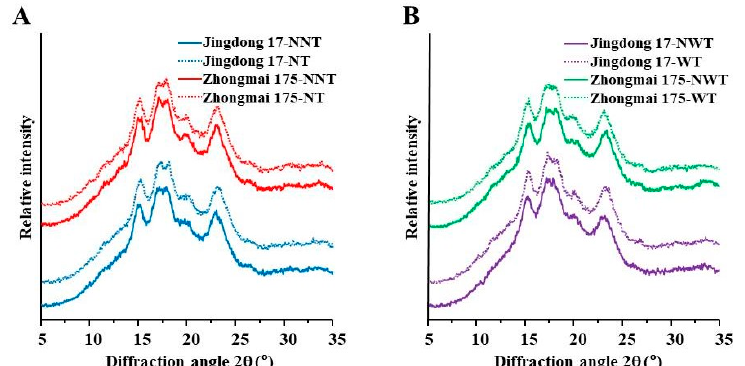
Figure 2. X-ray diffraction spectra of starch granules extracted from Zhongmai 175 and Jingdong 17 at non-nitrogen (NNT) and reduced nitrogen treatments (NT) ( A ), non-water (NWT) and reduced water (WT) treatments ( B ).